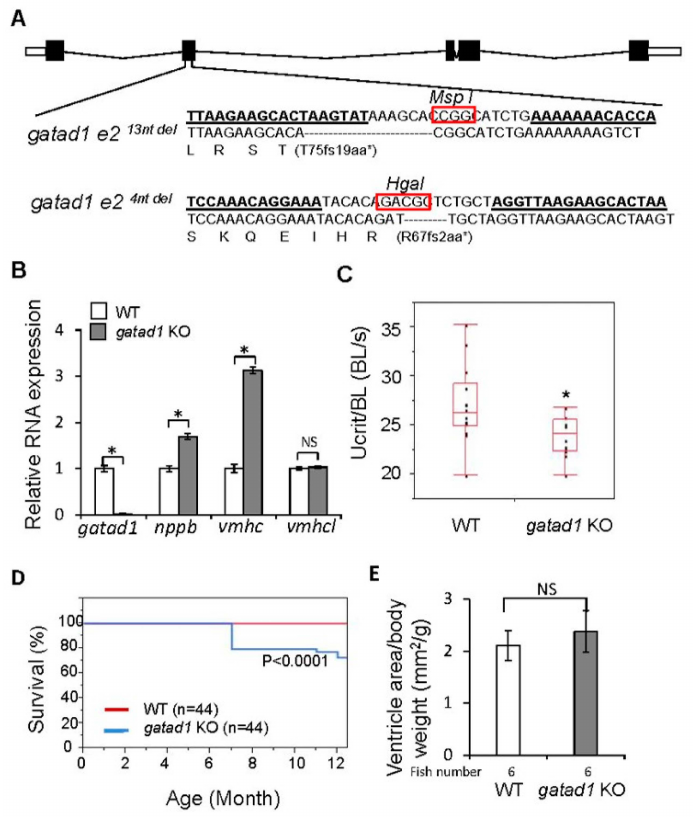
Figure 4. Generating and phenotyping gatad1 knock-out zebrafish. ( A ) Two TALEN mutants for gatad1 were generated. TALEN RNA binding sites within exon 2 are underlined. The restriction enzyme cut sites that facilitated genotyping are circled. The locations of the 13-bp and 4-bp deletions are shown below the wild type sequence, and the corresponding truncated peptides are indicated; ( B ) Fetal gene activation in the hearts of gatad1 KO fish. The RNA expression levels of gatad1 , nppb , vmhc and vmhcl are shown, as measured by real-time RT-PCR with gapdh as internal control. gatad1 expression was reduced by 98% in gatad1 13 ntdel homozygous mutant fish. The fetal genes nppb and vmhc were upregulated in gatad1 mutant fish; ( C ) Significantly reduced swimming capacity was observed in gatad1 13 ntdel homozygous mutant fish at 17 months. gatad1 13 ntdel homozygous mutant fish and age-matched controls were stressed by 0.3% ethanol from 2 hpf to 48 hpf and then fed with 4% cholesterol from 2 months of age; ( D ) Significantly reduced survival rate was observed in gatad1 13 ntdel homozygous mutant fish than in age-matched wild type fish after cholesterol and ethanol treatment; ( E ) Quantification of ventricle area shows no significant difference between wild type and gatad1 13 ntdel homozygous mutant fish after cholesterol and ethanol treatment. * p < 0.05; WT, wild type; KO, knock-out. NS, not